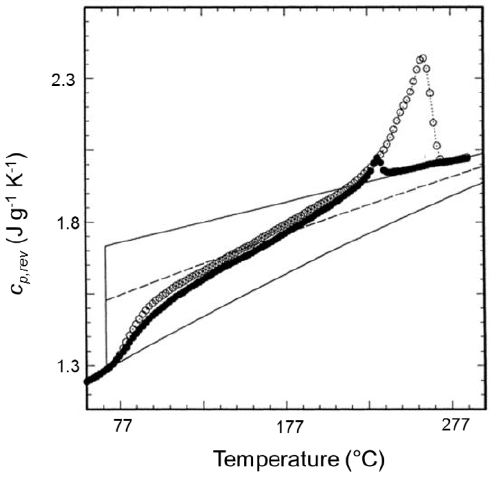
Figure 18. Reversing-specific heat capacity ( c p,rev ) of PET (filled circles) during stepwise quasi-isothermal TMDSC cooling from the melt ( p = 60 s and A T = 1.0 K, oscillation time around each temperature: 20 min). The thin solid lines are the solid and liquid specific heat capacities, as taken from [40]. The broken line is the calculated specific heat capacity for a 49% crystalline PET. The open circles describe the c p,rev curve of a melt-crystallized PET sample (crystallinity degree: 44%). (Reprinted (adapted) with permission from [5]. Copyright (1997) American Chemical Society).